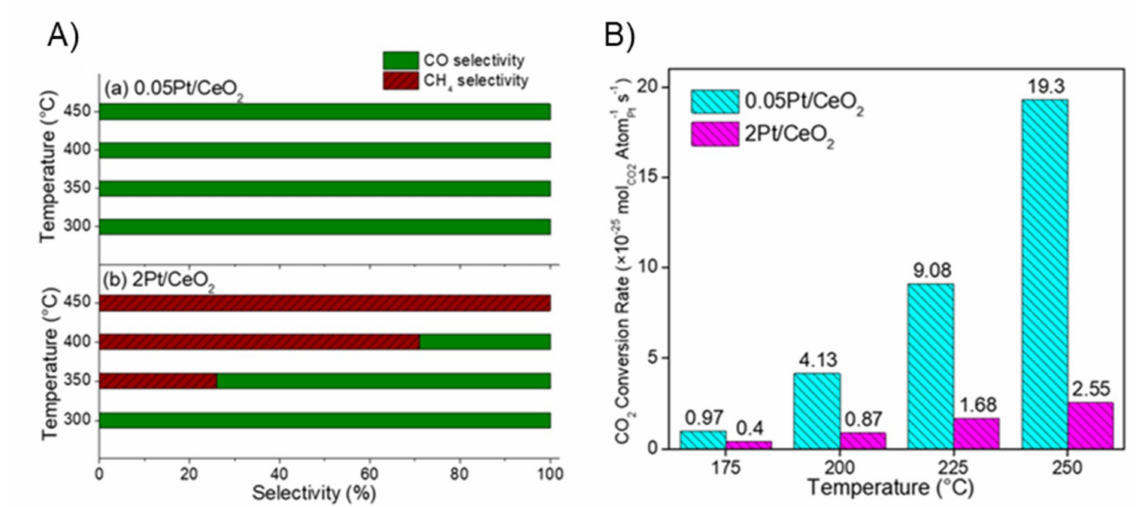
Figure 8. ( A ) CO 2 reduction selectivity of (a) 0.05 Pt/CeO 2 and (b) 2 Pt/CeO 2 toward CO and CH 4 ; ( B ) CO 2 conversion rate for 0.05 Pt/CeO 2 and 2 Pt/CeO 2 catalysts evaluated based on exposed Pt atoms in the temperature range from 175 to 250 ◦ C. Catalytic measurements were done on 50 mg of powder catalyst at a total flow of 40 mL min − 1 , resulting in a GHSV of ca. 48,000 mLg − 1 h − 1 (reprinted from ref [128] © 2018, American Chemical Society